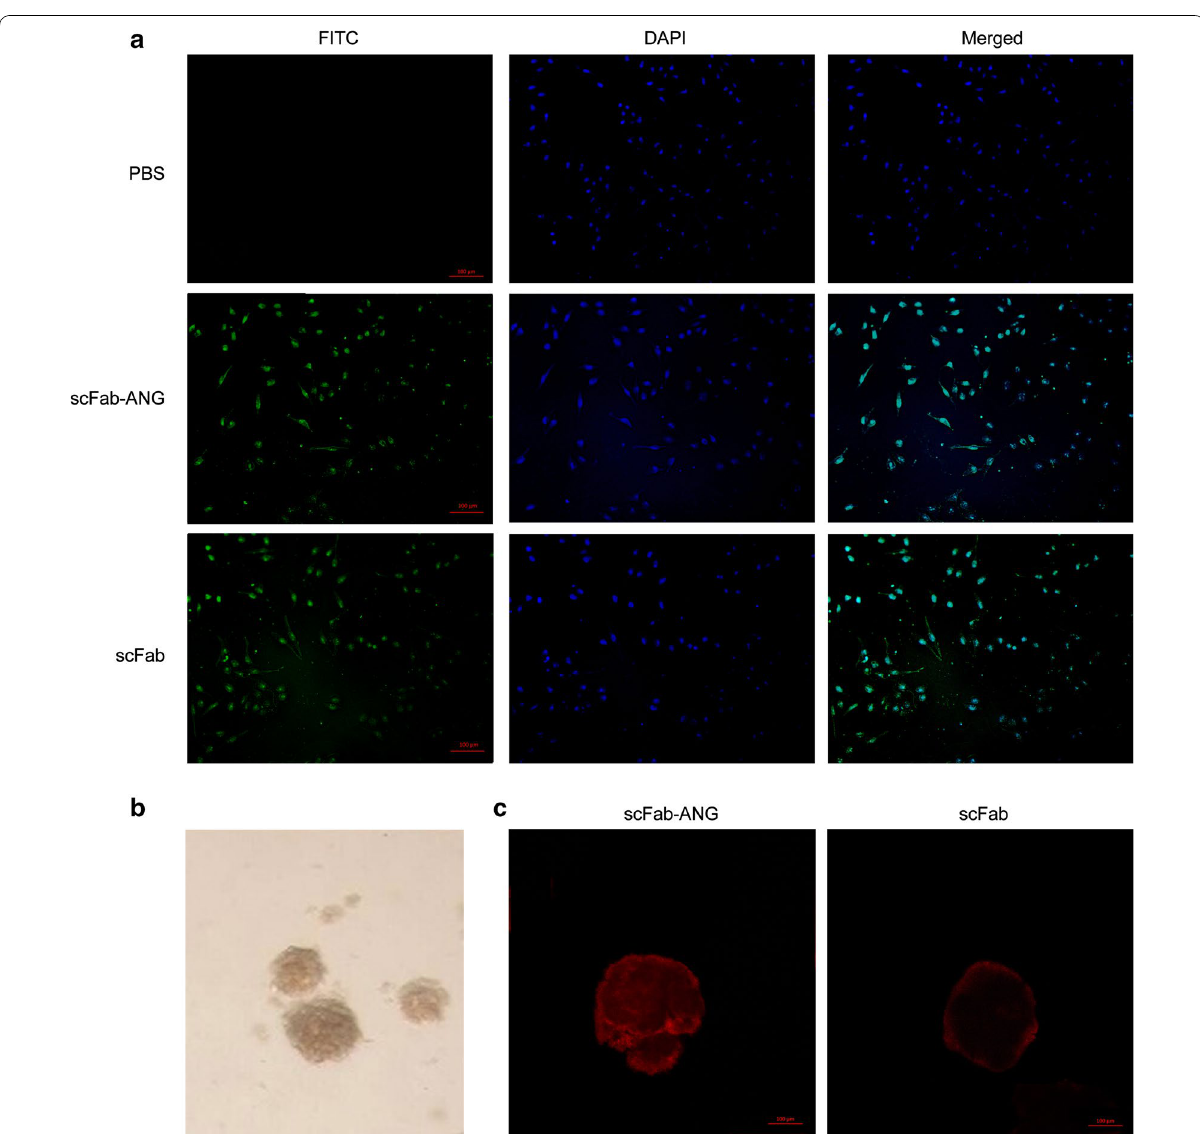
Fig. 2 Immunofluorescence assay and multicellular tumor spheroids permeability detection. a Fluorescent images of hepG2 cells bound by scFab-ANG and scFab, blue represents nuclei stained by DAPI, green represents binding sites of scFab-ANG/scFab staining by FITC. b U87 cells were cultured to form spheroids. c Cy3-labeled scFab-ANG (left) and Cy3-labeled scFab alone (right) were separately added to spheroids and cultured for 20 h, spheroids were imaged using confocal microscopy, red represents region stained by